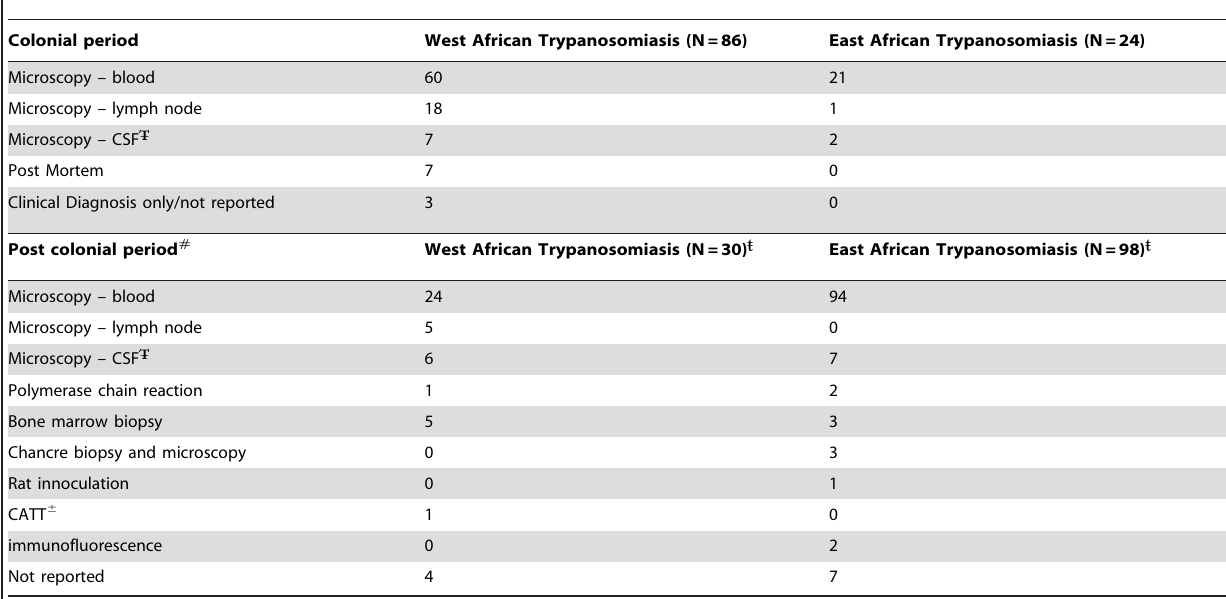
Table 2. Diagnostic means of Human African Trypanosomiasis among patients from non-endemic countries who acquired Human African Trypanosomiasis during the colonial period (1902–1966) and during the post-colonial period (1967–2012) #